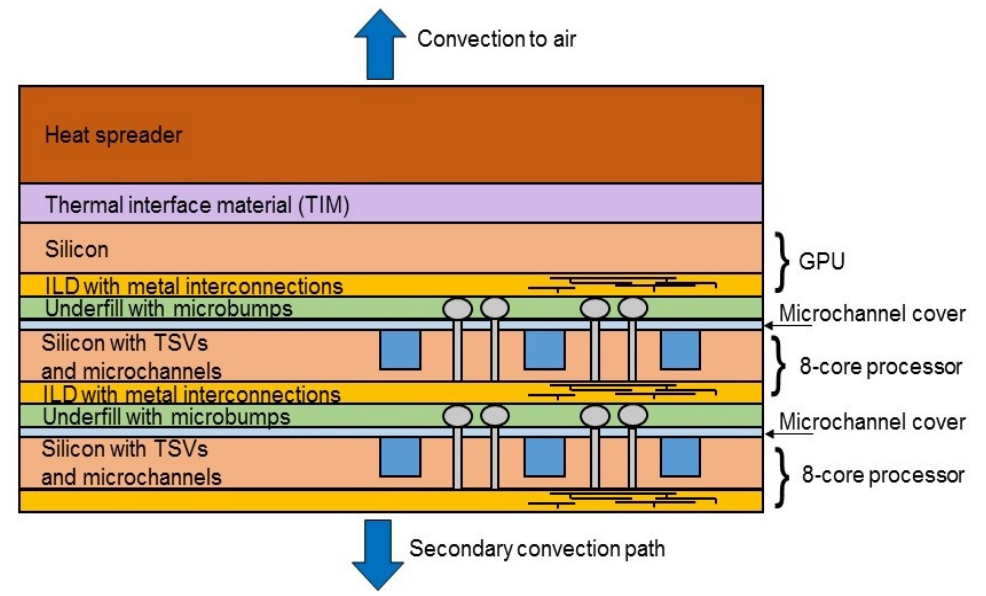
Figure 5. The 3D processor layers included in the 3D chip simulation model. ILD–inter-layer dielectric, TSV–through-silicon via. Table 1. 3D processor design parameters.